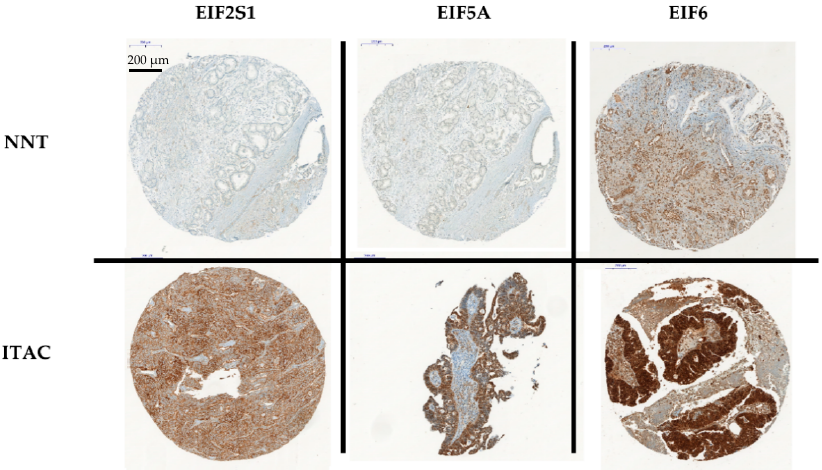
Figure 2. NNT ( upper row ), ITAC ( lower row ). Stained tissue sections using antibodies against EIF2S1, EIF5A and EIF6 in tissue micro arrays (TMAs) at different resolutions.